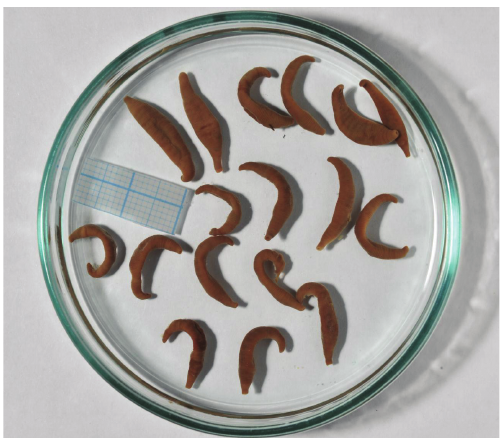
Figure 4: Exterior view and size variation of ethanol-fixed acan- thobdellids from the Chechuj River.